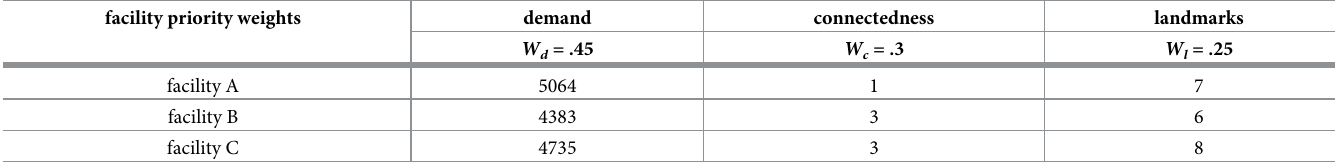
Table 3. A user constructed three-facility matrix for TOPSIS algorithm. We prioritize a facility’s demand attribute by setting W d = 0.45. If the main goal was to retain a well-connected allocation then W c would have the largest weight.